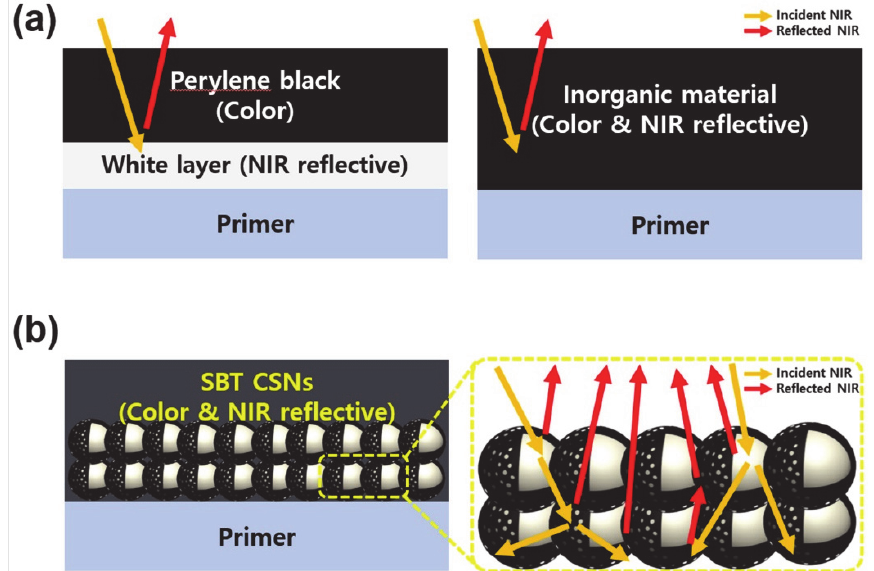
Figure 2. Schematic illustrations of NIR reflectance mechanisms of ( a ) previously reported bilayered (separate color/NIR reflective layer) organic perylene black with white surfacer system and monolayered (color + NIR reflective layer) heavy metal-based inorganic pigment and ( b ) black-colored, monolayered, and LiDAR-detectable SBT CSNs synthesized in this study without heavy metal inclusion.